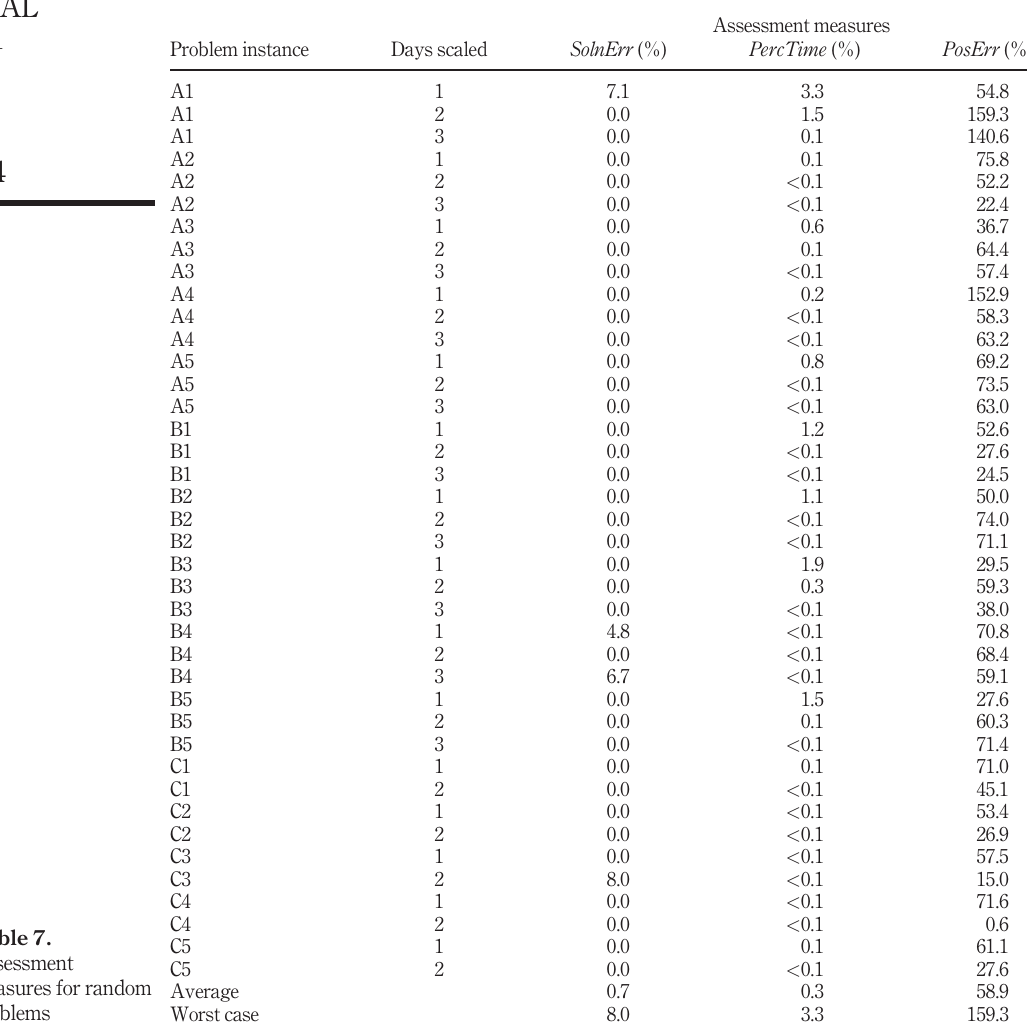
measures for random corresponding optimal solutions for various fl eet sizing problem instances. Liu (2016) reported heuristic fl eet size errors between 0 and 15% compared to the optimal for 50 small- scale problem instances. Raa (2015) reported average heuristic errors of about 0.5% for 80 problems with a small number of routes and average errors of about 0.4% for 80 problems with a large number of routes. Vidovi (cid:1) c et al. (2014) reported heuristic solutions within 4 – 7% of optimal for 100 small-scale problem instances. Similarly, Salhi et al. (2013) achieved heuristic results within about 5% of the optimal on average for 36 small-scale problem